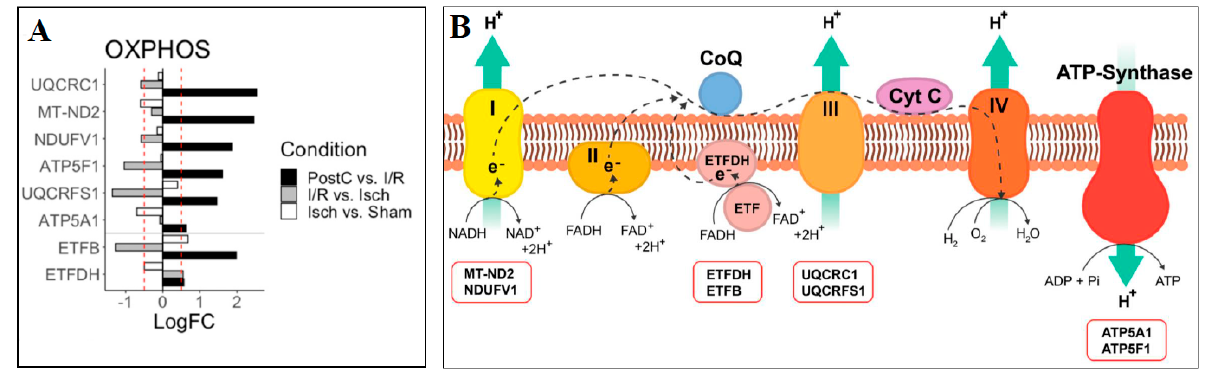
Figure 2. Oxidative phosphorylation (OXPHOS)related differentially regulated proteins. ( A ) The changes in expression of proteins (Log FC) during ischemia (Isch), ischemiarevascularization (I/R) and ischemic post-conditioning (PostC); red dashed lines indicate absolute Log FC > 0.5; ( B ) A